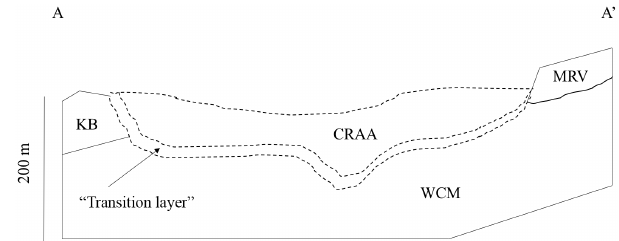
Figure 2. Geological cross section along A–A (cid:48) in Fig. 1 (adapted from Dafny and Silburn, 2014). KB – Kumbarilla Beds; MRV – Main Range